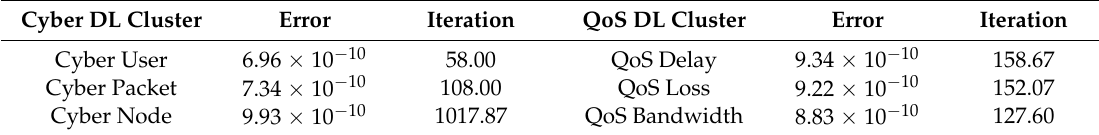
Table 11. Deep Learning Cluster Validation (4 × 4 Nodes).